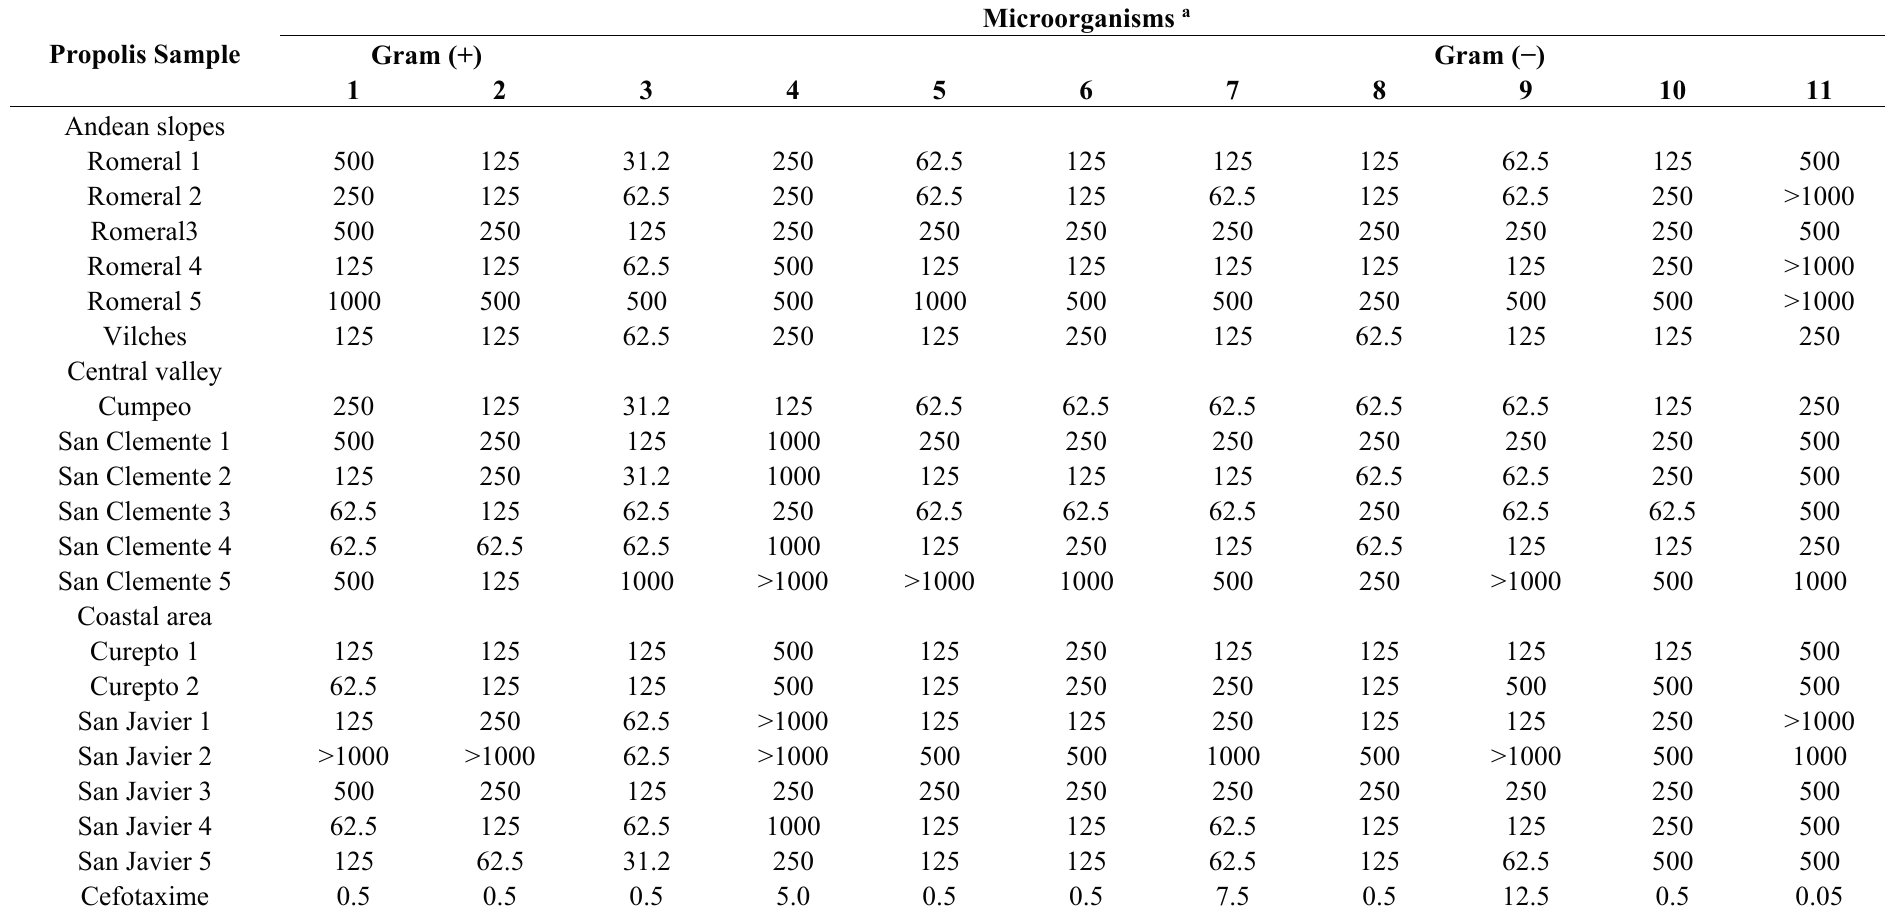
Table 1. Antimicrobial activity of methanol extracts of propolis from the Andean slopes (“precordillera”), central valley, and coastal area (“secano costero”), Región del Maule, Chile. Results are presented as MIC values in